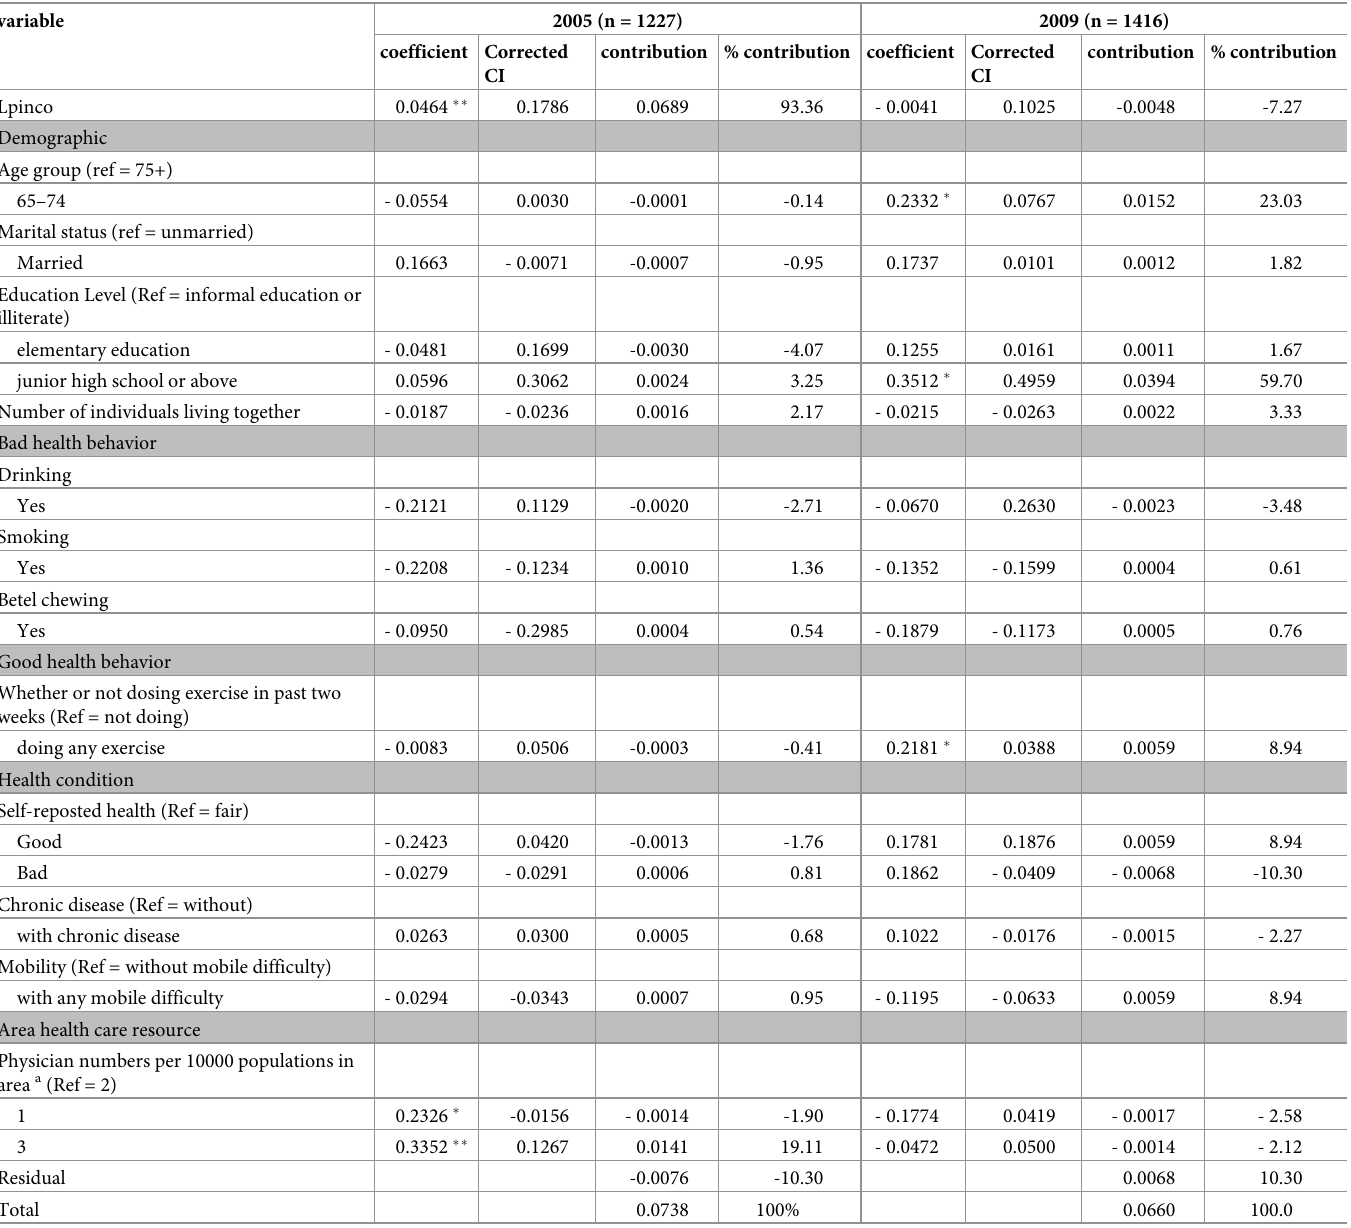
Table 3. Variable contributions to unequal use of health check-ups in 2005 and 2009 from probit regression,